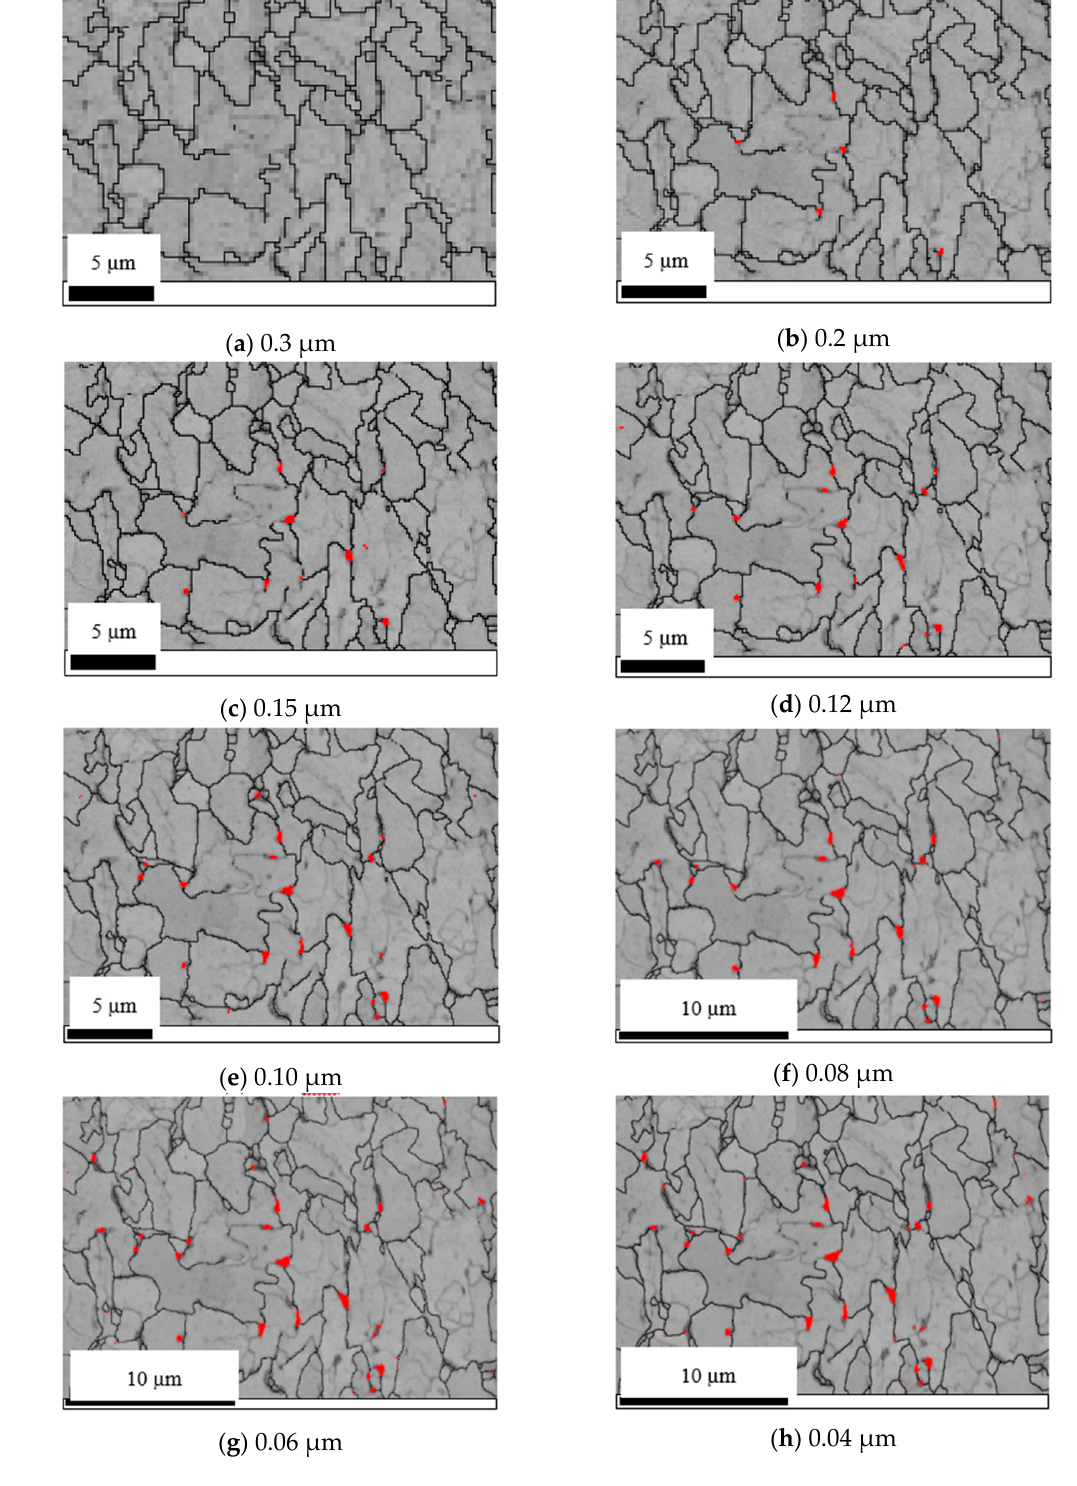
Figure 7. The morphology and distribution of retained austenite in X90 steel at different step sizes ( a : 0.3 μ m; b : 0.2 μ m; c : 0.15 μ m; d : 0.12 μ m; e : 0.10 μ m; f : 0.08 μ m; g : 0.06 μ m; h : 0.04 μ m).